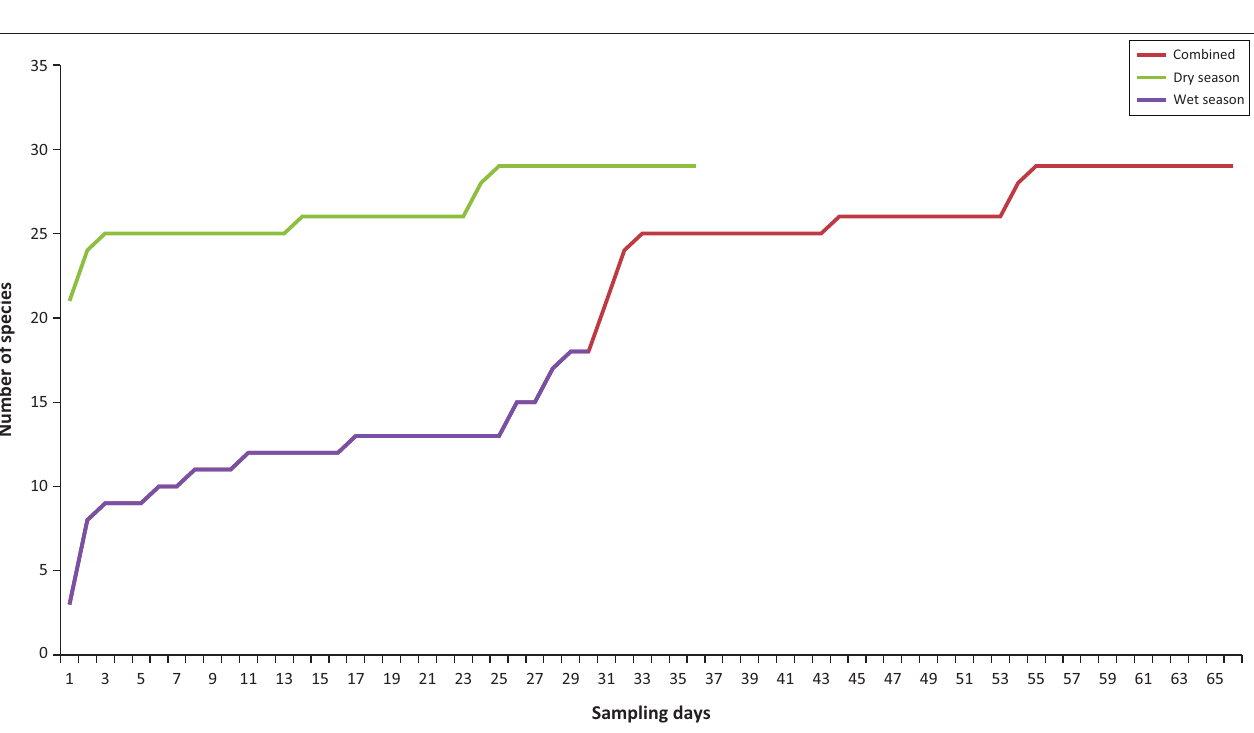
FIGURE 2: Species accumulation curve with a logarithmic regression equation for waterbirds at Mole National Park.